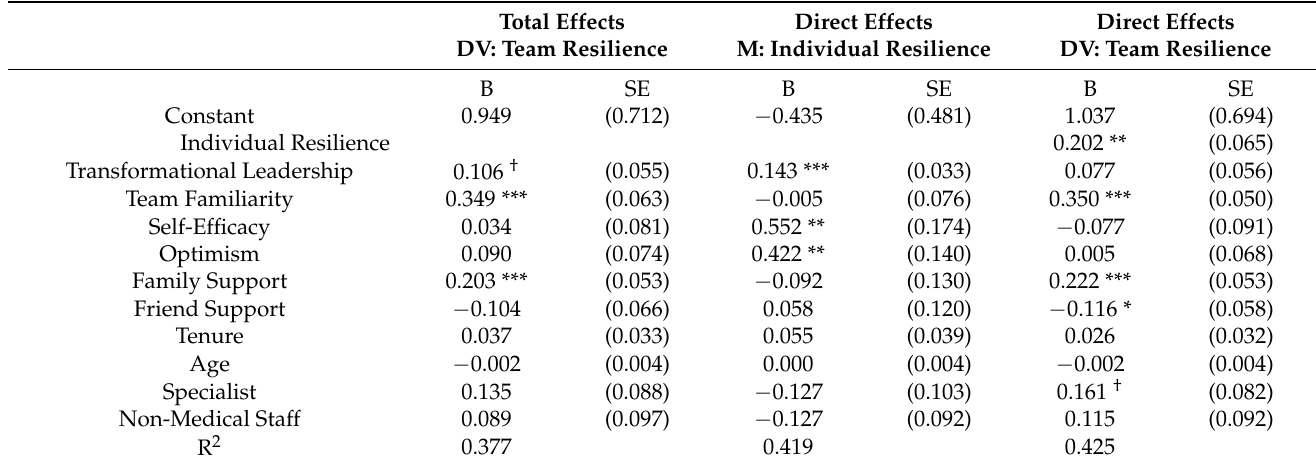
Table 5. Structural Equation Model (SEM).